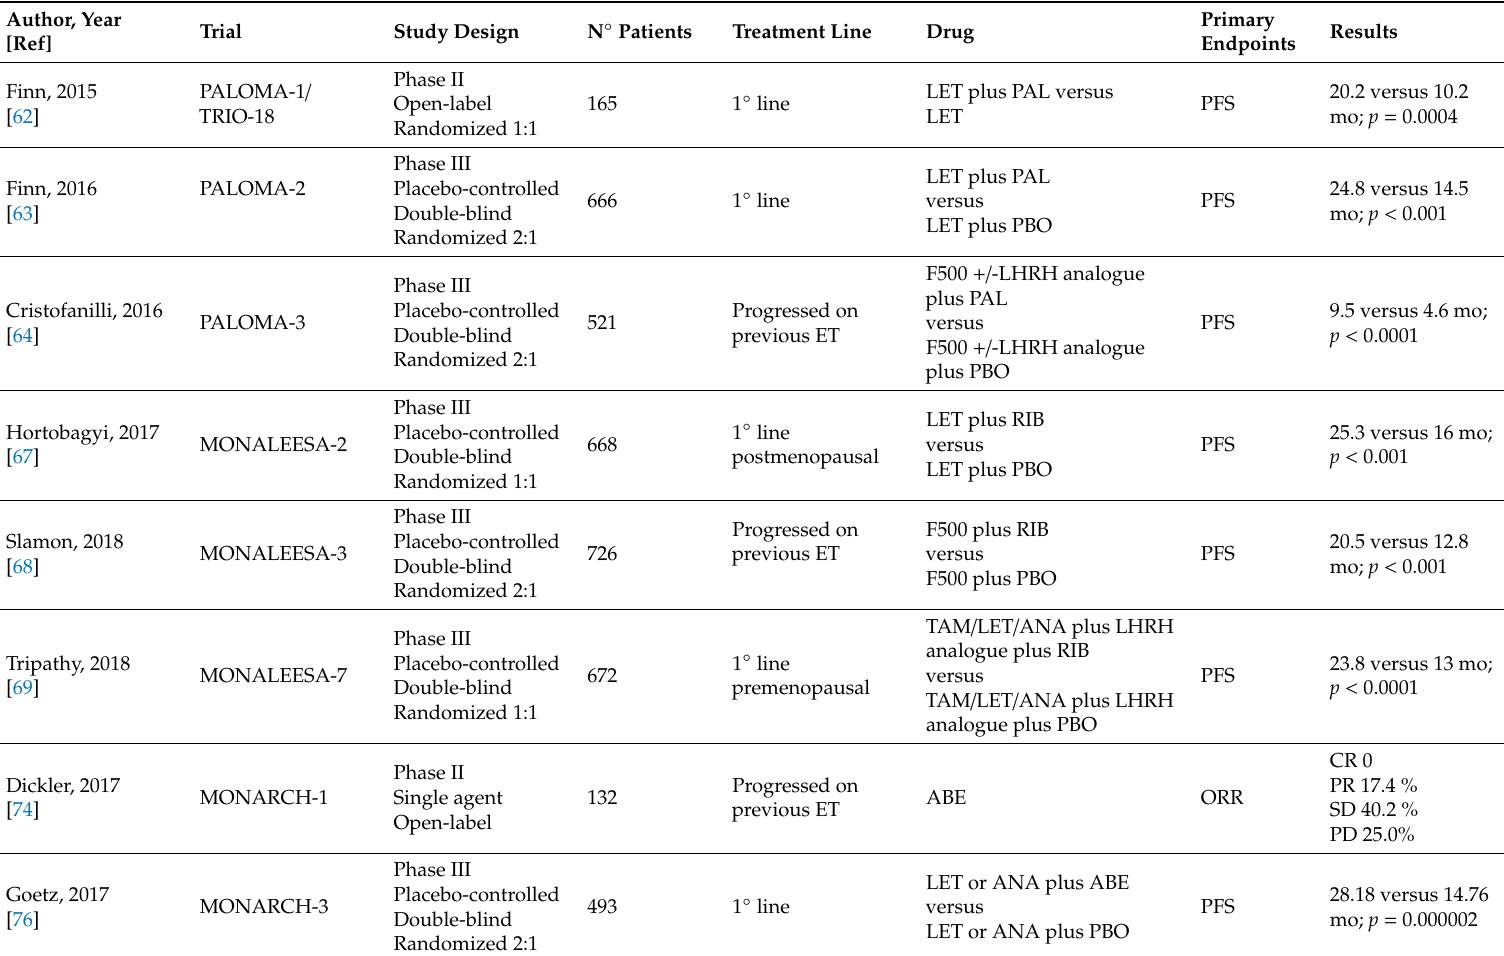
Table 2. Pivotal trials on the cyclin-dependent kinase (CDK)4 / 6